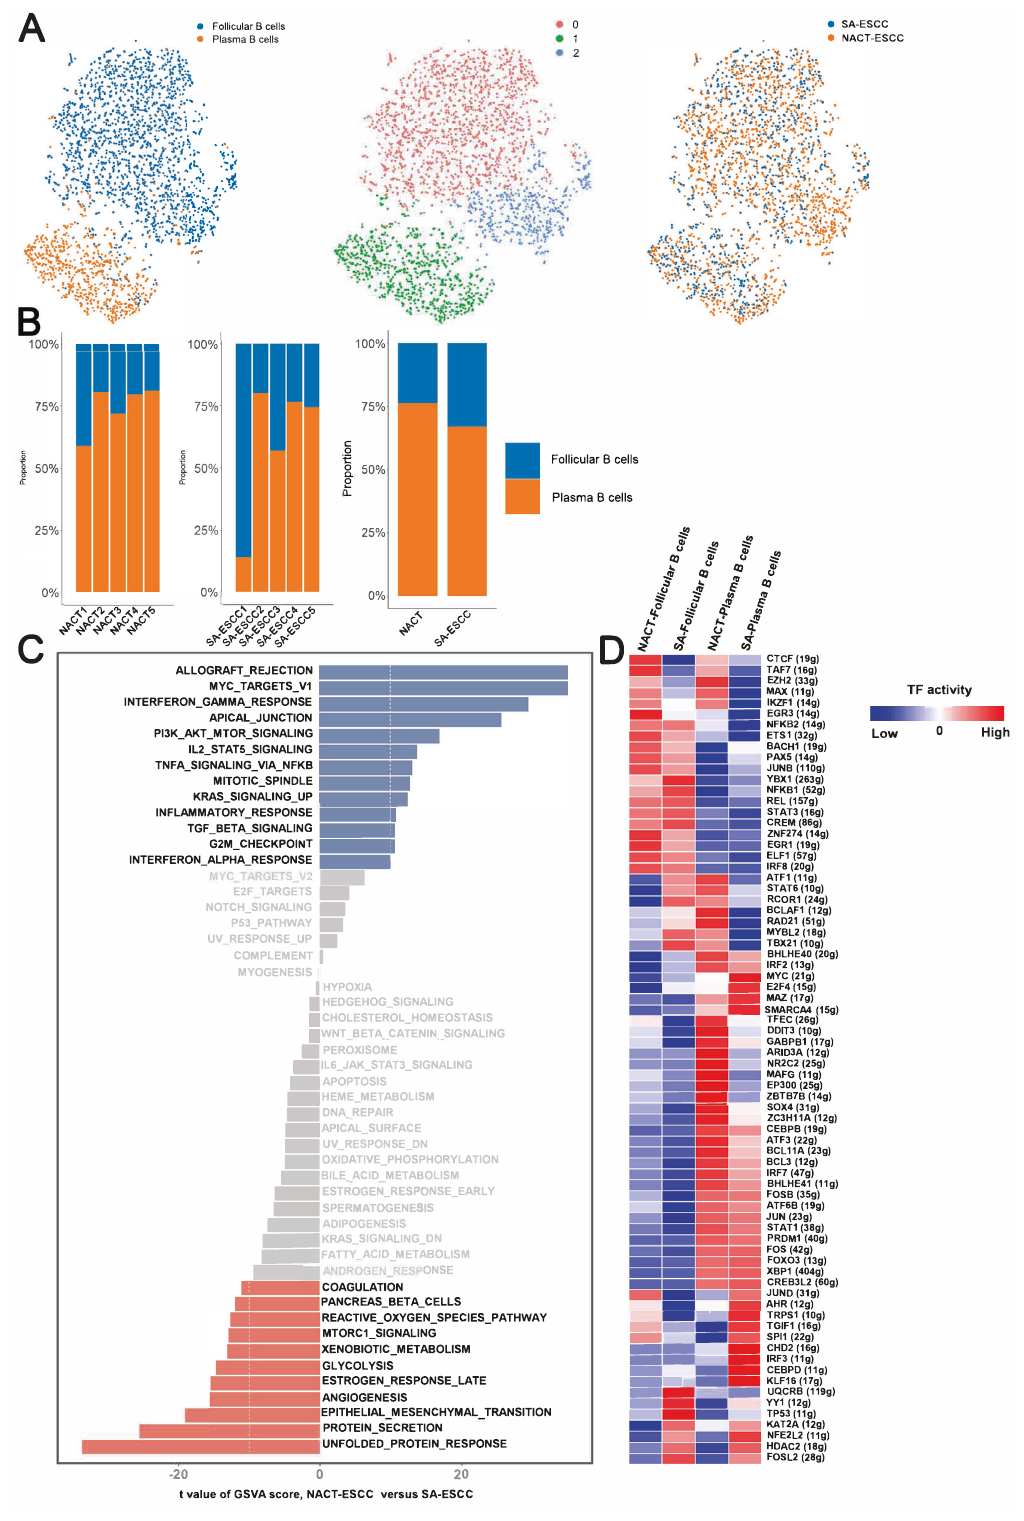
Fig. 6 The scRNA Pro fi les for B cells in SA-ESCC and NACT-ESCC. A The TSNE plot of B cells in SA-ESC and NACT-ESCC samples. B The proportion of each B cell subtypes in SA-ESCC and NACT-ESCC samples. C GSVA analysis in plasma B cells from different conditions. D Heatmap showing the activity of TFs in each B cell subtypes in each condition. The TF activity is scored using